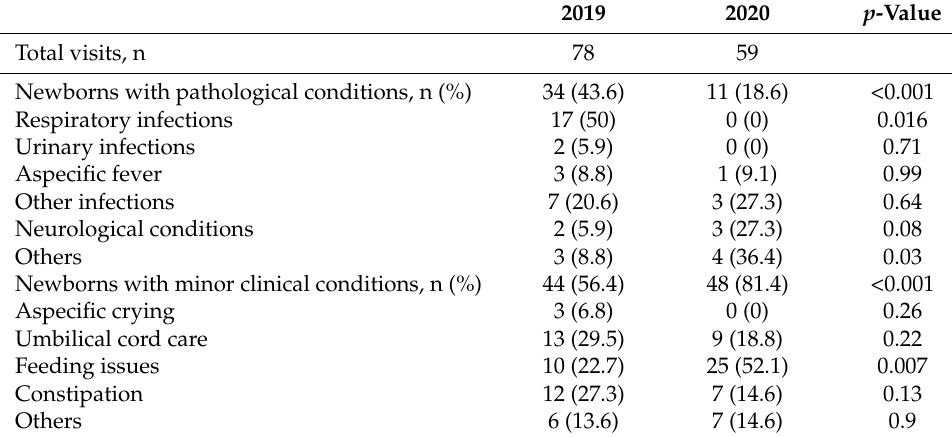
Table 2. Pediatric emergency department visits of the neonatal population (age < 28 days) in March– April 2019 (non-COVID-19) compared with the same period in 2020 (COVID-19).